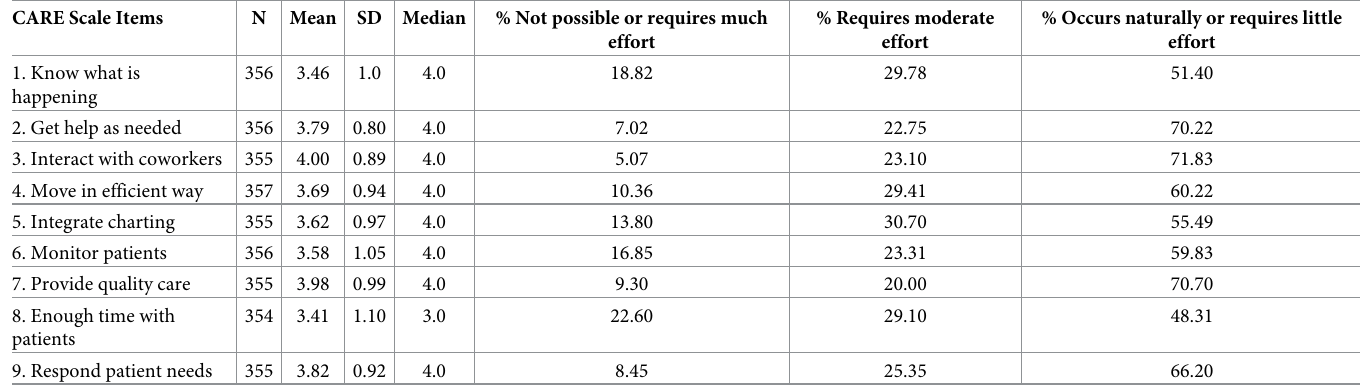
Table 10. Phase 4 CARE items response